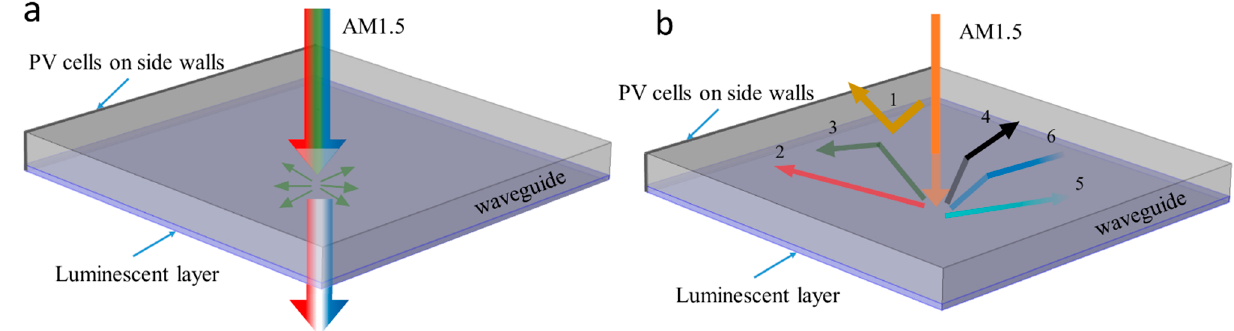
Figure 1. ( a ) Mechanism of an LSC as a solar spectrum splitter and solar concentrator and, ( b ) Operation and loss mechanisms in an LSC: (1) Fresnel reflection loss, (2 and 3) Light guiding of photons emitted outside the escape cone via TIR to PV cells at the sidewalls of the planar waveguide, (4) Emission losses of photons emitted within the escape cone, (5) Internal absorption losses, (6) Surface scattering losses at the waveguide/air boundary.